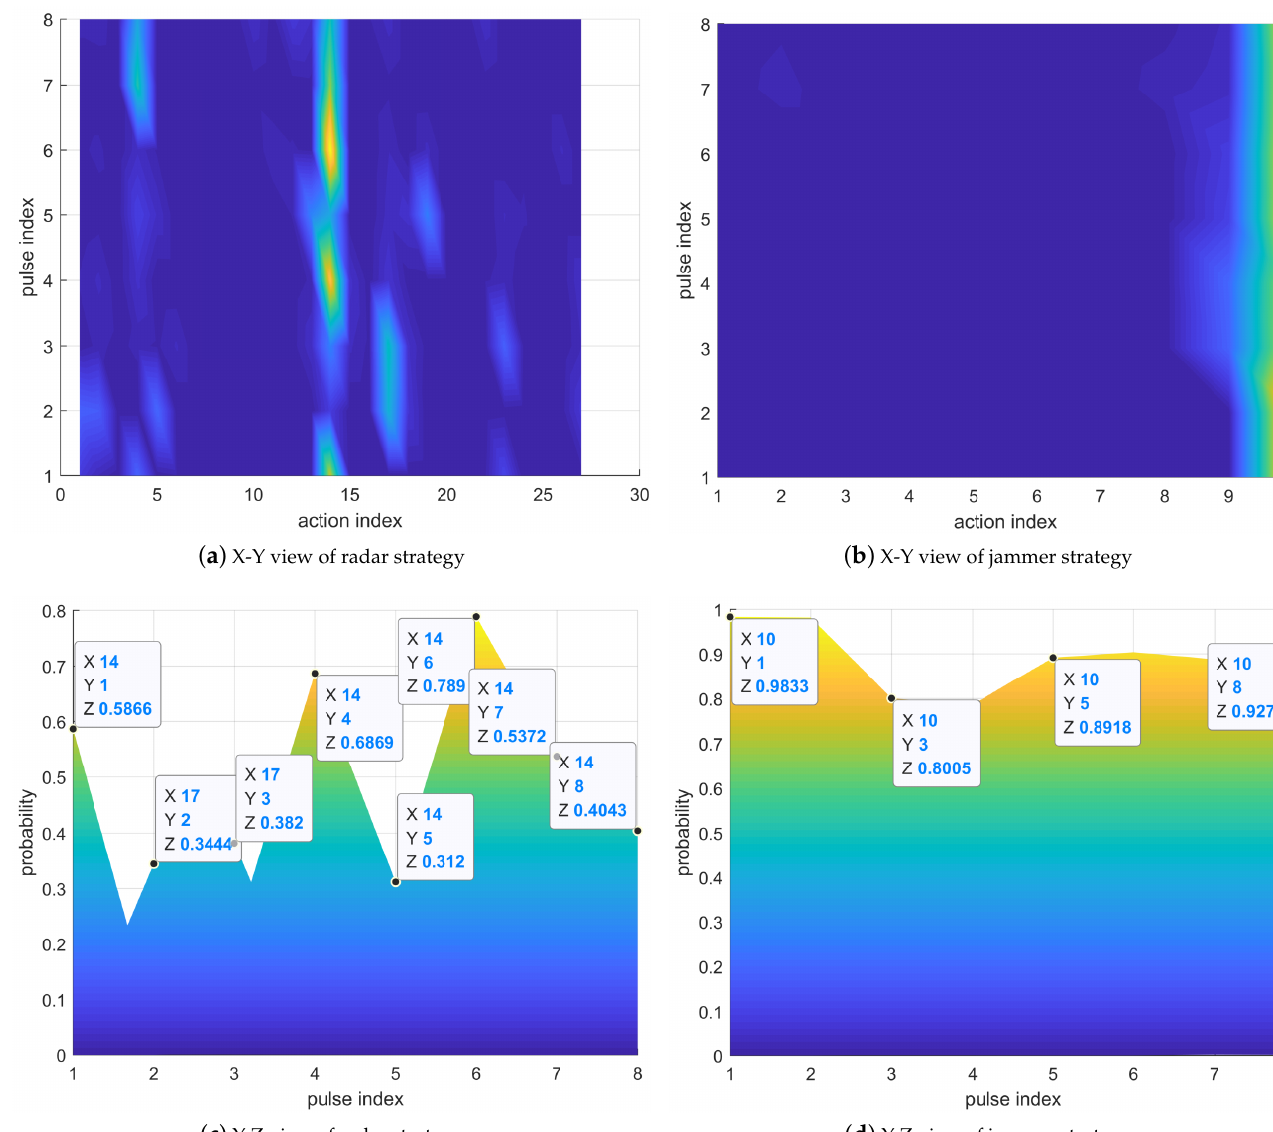
Figure 13. Approximate NE strategies with a quantization step of